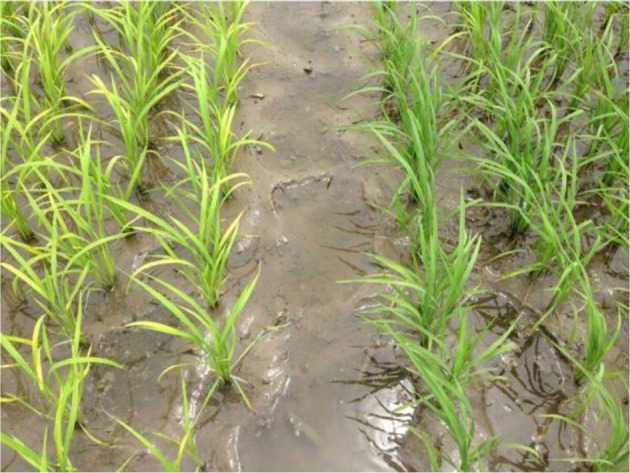
Genotype Z802 (right) and pgl
(left) at the seedling stage.